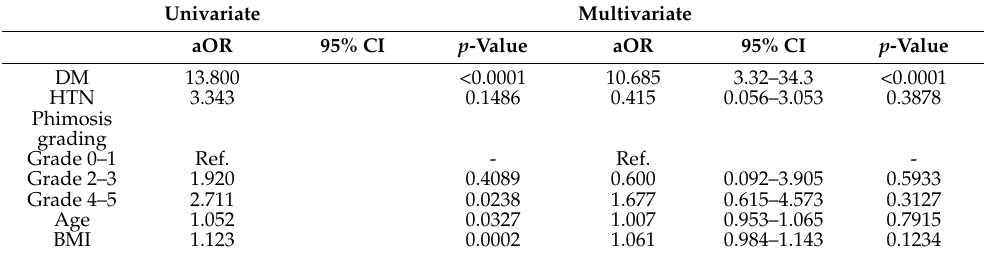
Table 4. Logistic regression analysis.